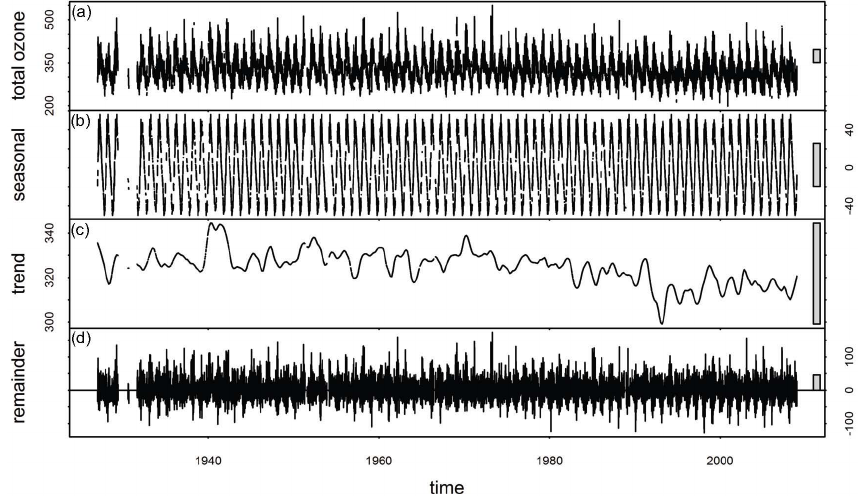
Fig. 3. Decomposition plot of the Arosa total ozone record based on a Seasonal-Trend decomposition procedure based on LOESS (STL): (a) daily mean values, (b) seasonal component, (c) trend component, (d) remainder. For convenient reference, right-hand grey bars in (a–d) refer to the same magnitude (40DU). Gaps in the time series indicate periods with missing data. All panels are for 1927–2008. LOESS was computed using the stl-R function with parameters t.window=549, t.degree=1, s.window=”periodic”, and